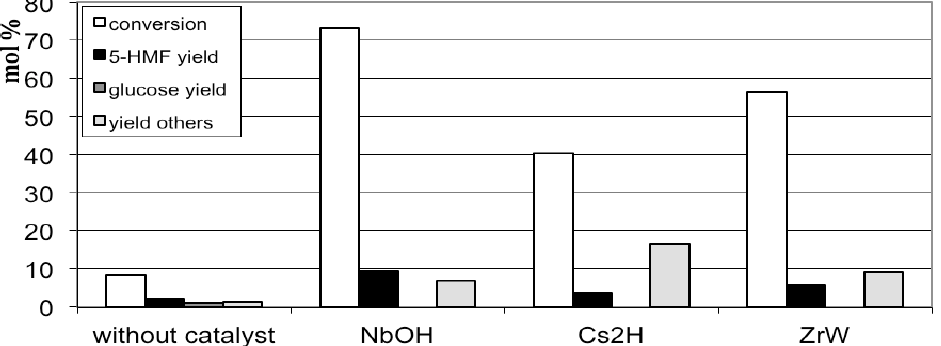
Figure 6. Fructose conversion in aqueous media at 150 °C in the presence of 1 Cs HPW O , ZrW and NbOH. 2 12 40